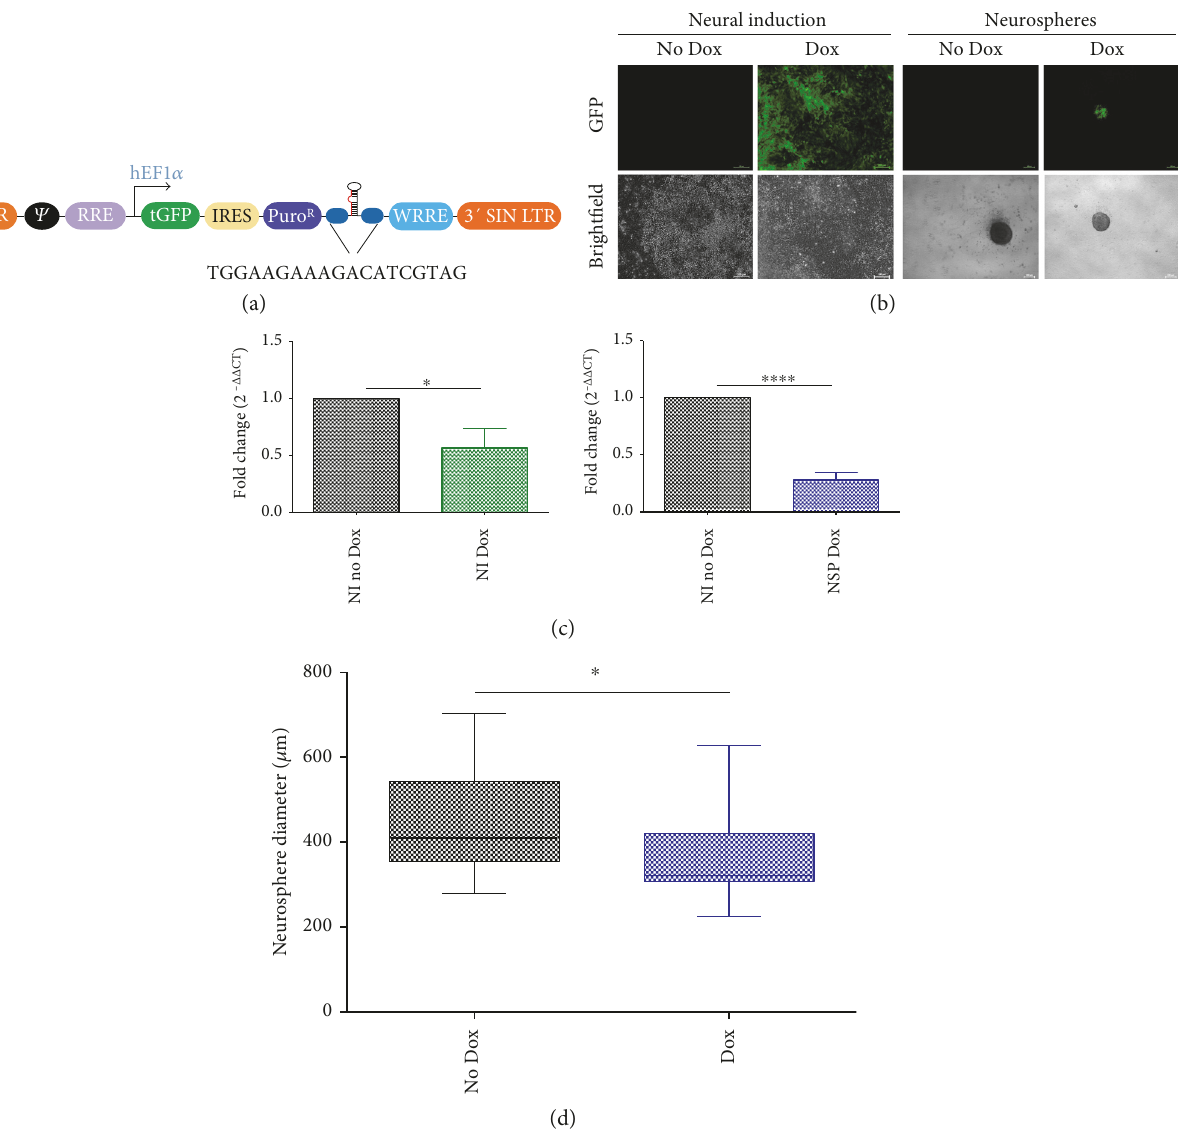
Figure 2: E ffi cient knockdown of WDR62 expression in hPSC-derived neural progenitors. (a) Map of inducible lentiviral shRNA vector and targeted sequence of WDR62. (b) GFP and corresponding bright fi eld images of WDR62 shRNA-transduced hPSC-derived neural progenitors with versus without Dox treatment at neural induction and NSP stages. (c) Gene expression analyses showing downregulation of WDR62 expression in WDR62 shRNA-transduced hPSC-derived neural progenitors treated with Dox versus no Dox treatment at neural induction ( P = 0 04 ) and NSP stages ( P = 7 3 E − 6 ) ( n = 4 and n = 6 independent experiments, resp., > 3 NSPs per experiment). Two-tailed t -test was used to assess signi fi cance. (d) Diameter measurements of WDR62 shRNA-transduced hPSC-derived NSPs treated with Dox versus no Dox controls ( n = 3 independent experiments, > 3 NSPs per experiment). Mann – Whitney U test was used to assess signi fi cance. ∗ P < 0 05 ; ∗∗∗∗ P < 5 0 E − 05 . NI: neural induction; NSPs: neurospheres; Dox: